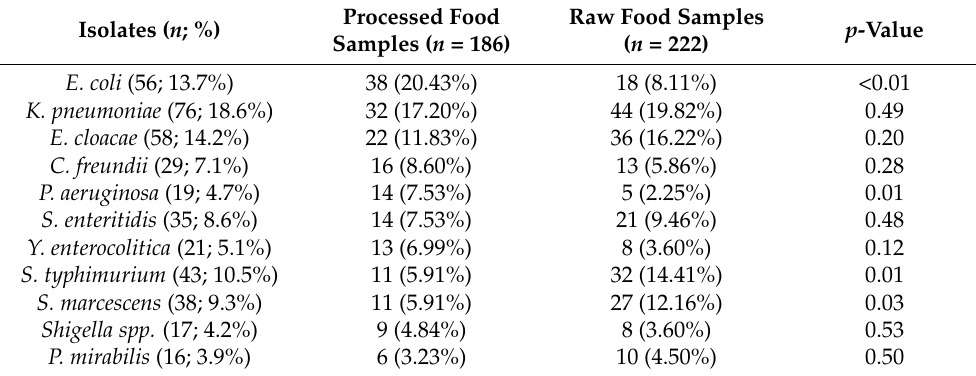
Table 1. Gram-negative isolates from processed and raw food samples ( n =